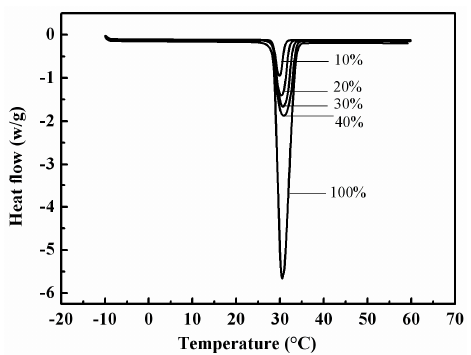
Figure 3. DSC curves of RT28 and the RT28/EP composite PCMs with 10, 20, 30 and 40 wt % of RT28, respectively.